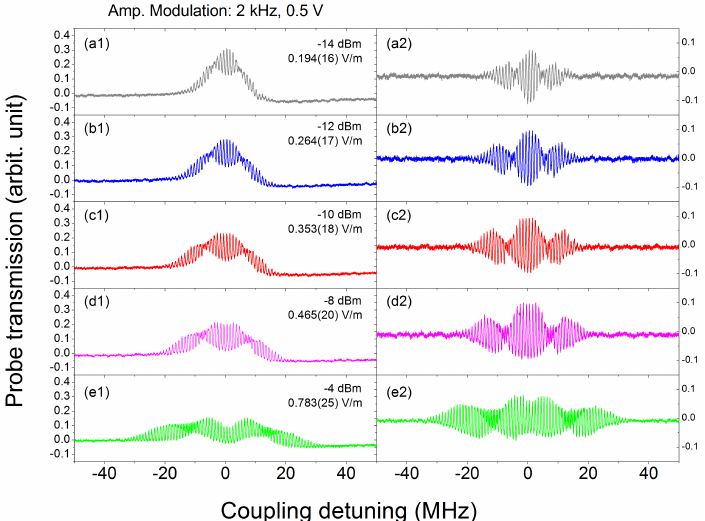
Figure 6. The measurement of optical response of MW at different RF powers varying from − 14 to − 4 dBm ( a1 , b1 , c1 , d1 , e1 ) and the dynamical signal extraction ( a2 , b2 , c2 , d2 , e2 ). The laser powers are fixed at the optimized intensities. When the RF power increases up − 10 dBm, the response has a large amplitude and nearly gets saturated, implying an optimized RF power.